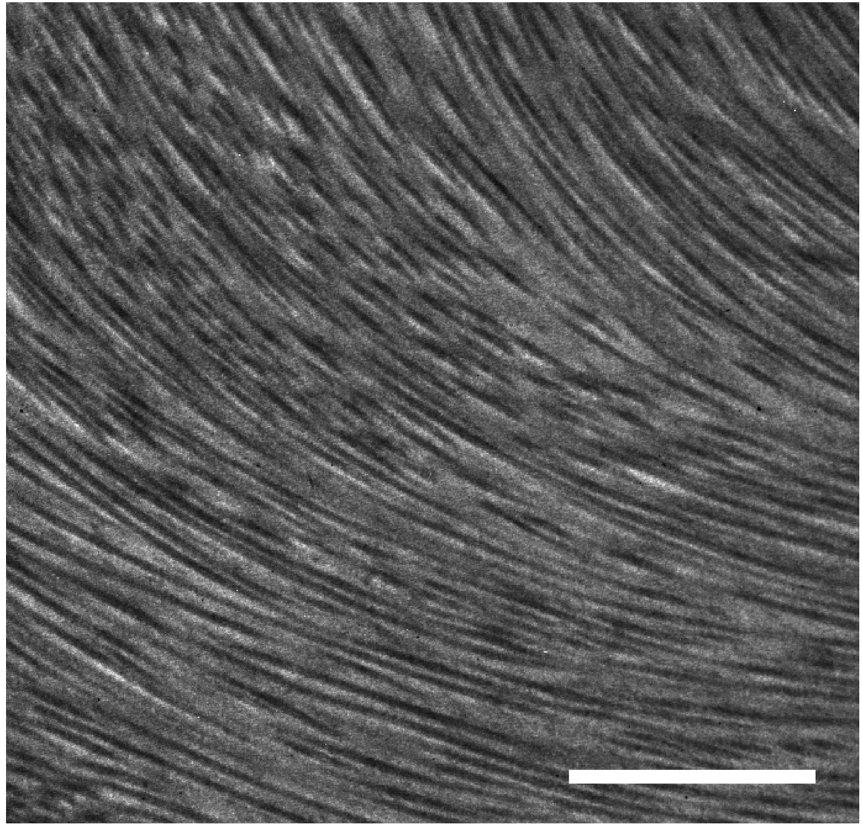
Figure 2. Transmission electron microscopy . Transmission electron microscopy demonstrating retained collagen fibrils after decellularization treatment. Bar, 2 m m.